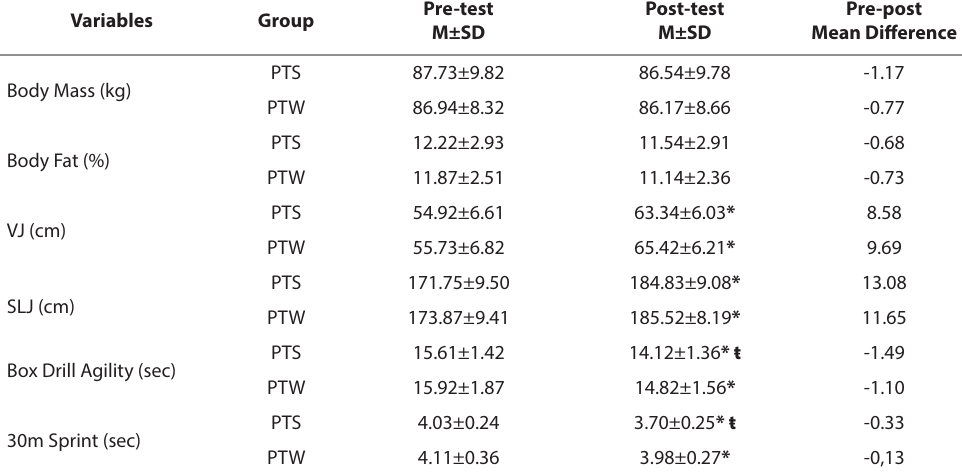
TABLE 3. Effect of 6-Week Plyometric Training on Physical Performance Parameters of PTS and PTW